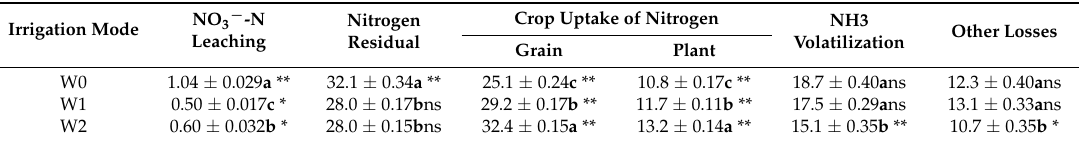
Table 3. Directions of fertilizer nitrogen under different irrigation modes % ( a , b and c in the figure represented differences between groups for significance analysis).